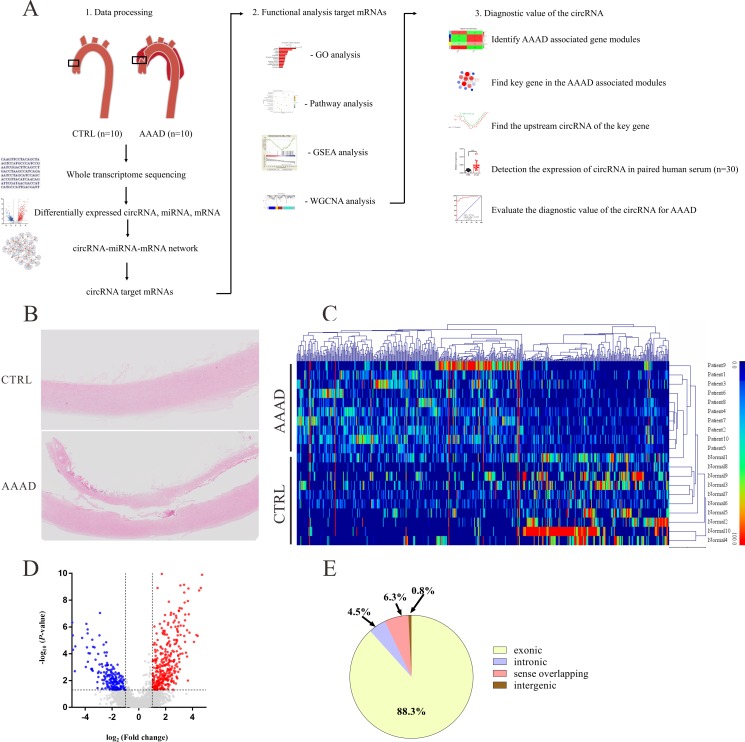
Differential expression of circRNAs between human acute Stanford type A aortic dissection (AAAD) tissues and normal aortic tissues.(A) The flowchart of this study. (B) Hematoxylin and eosin (HE)–stained sections showing the AAAD. (C) Hierarchical cluster analysis of all target circRNAs. 506 circRNAs were significantly differentially expressed (P<0.05, false discovery rate, FDR<0.05, fold change>2) between human AAAD tissues and normal aortic tissues. Among these, 320 circRNAs were upregulated and 186 circRNAs were downregulated in AAAD tissues. (D) Differentially expressed circRNAs were displayed by volcano plots. The blue and red parts indicated >2 fold decreased and -increased expression of the dysregulated circRNAs in AAAD tissues, respectively (P< 0.05). (E) Classification of differentially expressed circRNAs.